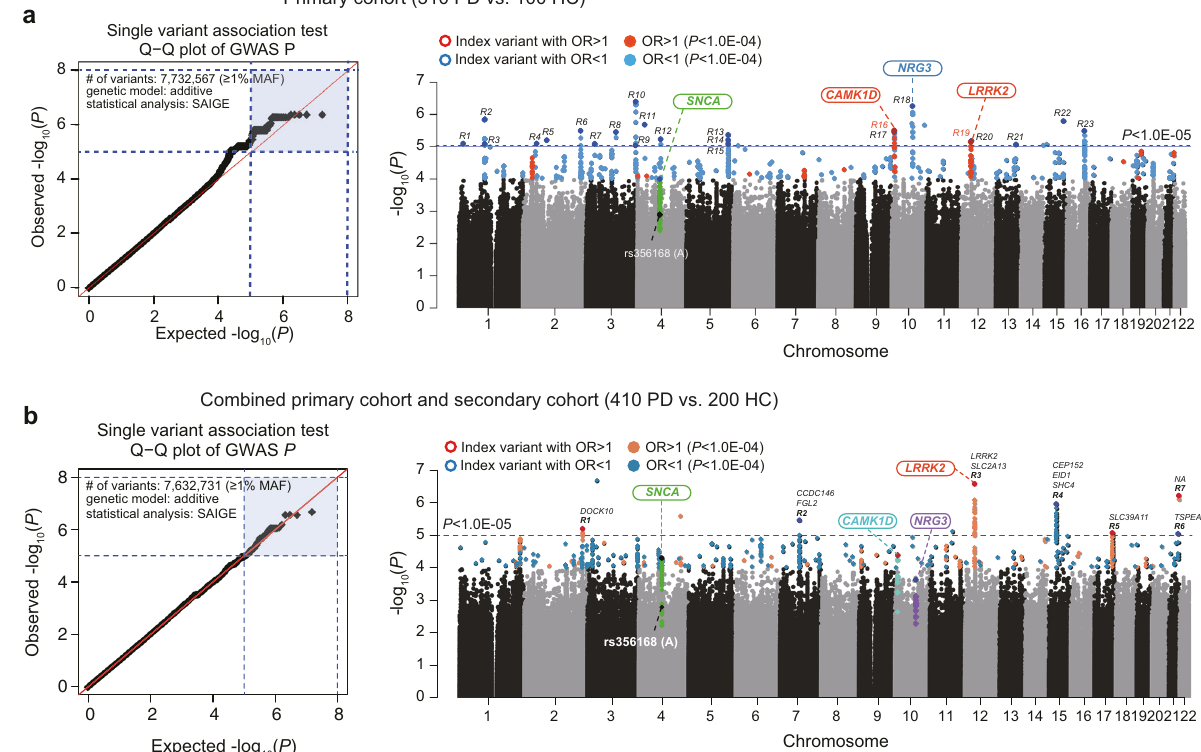
Fig. 2 SNVs associated with risk of PD. a , b Common SNVs detected in the primary ( a ) and combined ( b ) cohorts by applying logistic mixed models to detect risk SNVs and SNVs most signi fi cantly associated with PD. HC healthy control, PD Parkinson ’ s disease, SNVs single-nucleotide